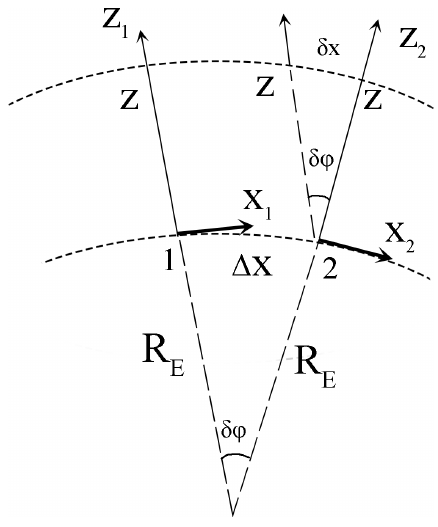
Figure 2. The rotation of the local Cartesian coordinate frame at each step along the Earth’s surface h x on a small angle δϕ ≈ (cid:49)x/R E in radians, while (cid:49)x = h x . The following strong inequali- ties are valid for h x (cid:28) L z (cid:28) R E . At the Earth’s surface z =